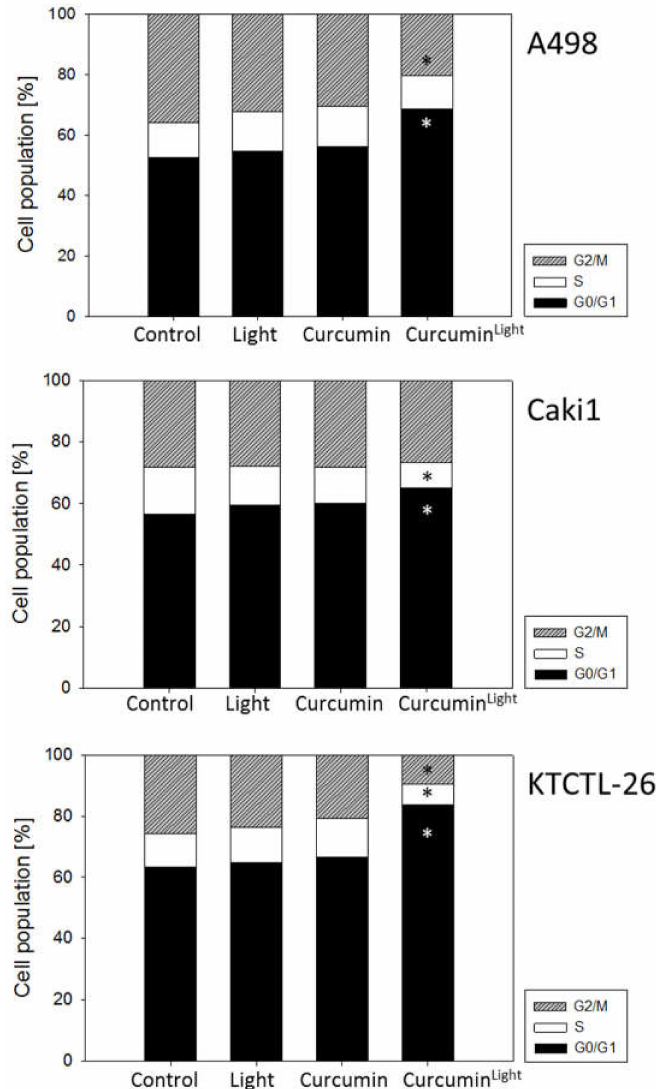
Figure 5. Cell cycle analysis of A498, Caki1, and KTCTL-26 cells treated with 0.2 µ g/mL curcumin for 1 h, with or without irradiation (controls remained untreated). Analysis was done 24 h following curcumin exposure. The cell population is expressed as a percentage of the total cells analyzed. One representative experiment of three is shown. Mean SD interassay < 40%, mean SD intraassay < 10%. * Indicates significant difference to